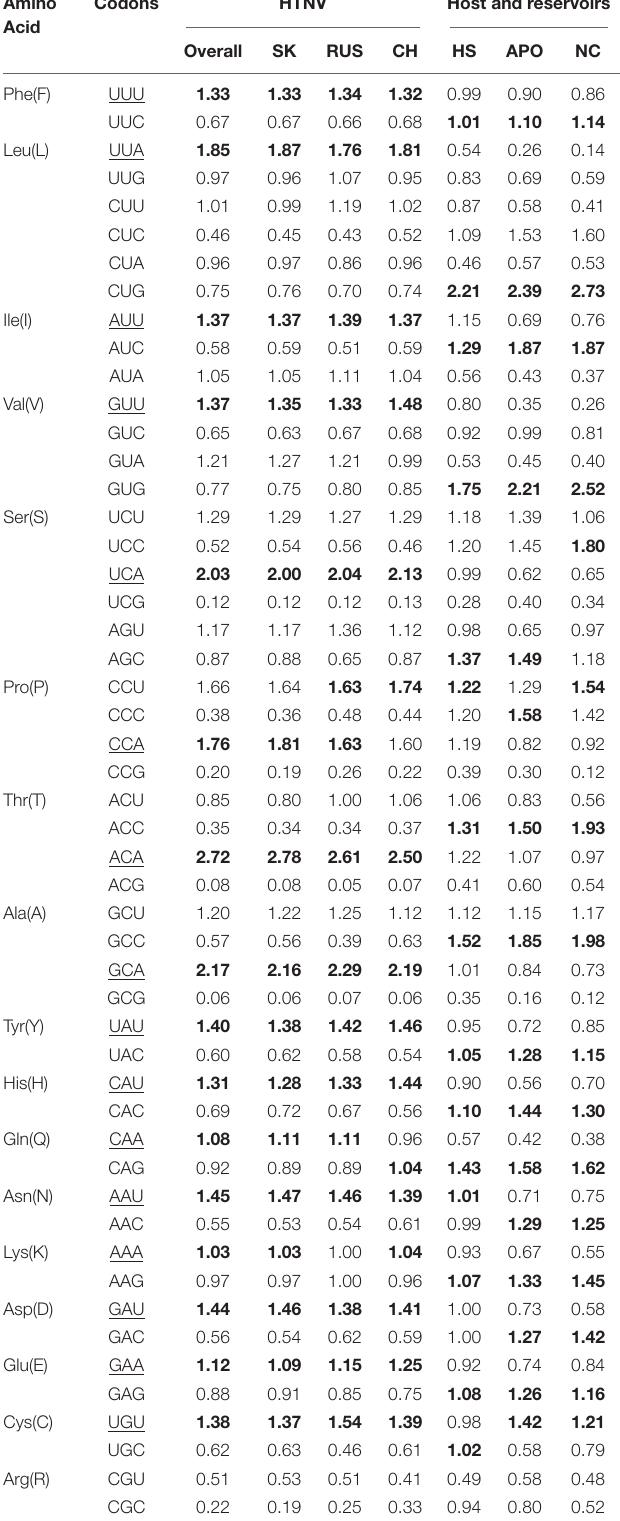
TABLE 1 | Relative synonymous codon usage (RSCU) patterns of HTNV, host, and natural reservoirs. Amino Codons HTNV Host and Acid